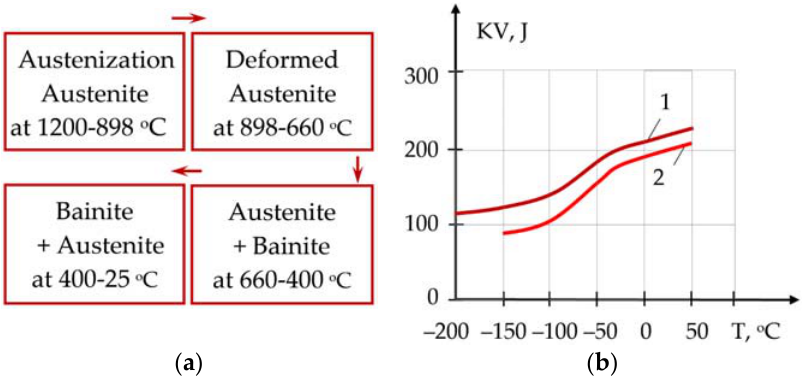
Figure 9. ( a ) TMCP diagram of Mn-steel. Data from [49]; ( b ) impact energy for medium manganese steel: ( 1 ) medium manganese steel, %: 7.22 Mn; 0.093 C; 0.49 Si; 0.013 Al; 0.005 P; 0.007 S. Data from [50]; ( 2 ) medium manganese steel, %: 0.04 C; 0.12 Si; 4.87 Mn; 4.98 Ni; 0.0047 S; 0.011 P; 0.03 Nb. Data from [51].